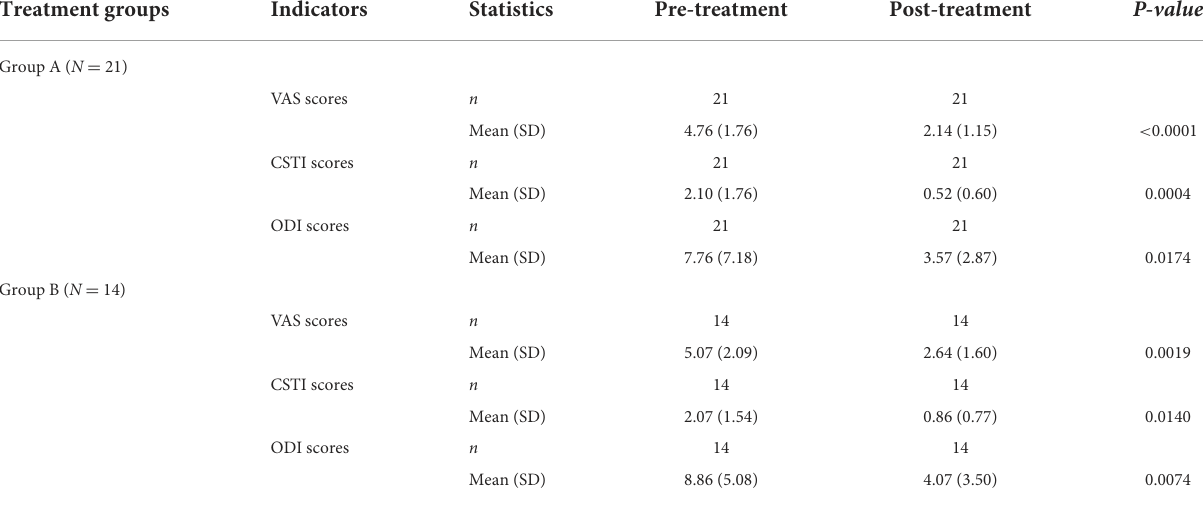
TABLE 8 Intragroup comparison of secondary indicators before and after treatment in patients with back